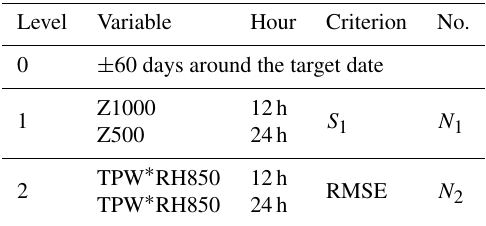
Table 2. Parameters of the reference method with moisture vari- ables (2Z-2MI). The conventions are the same as those in Table 1.